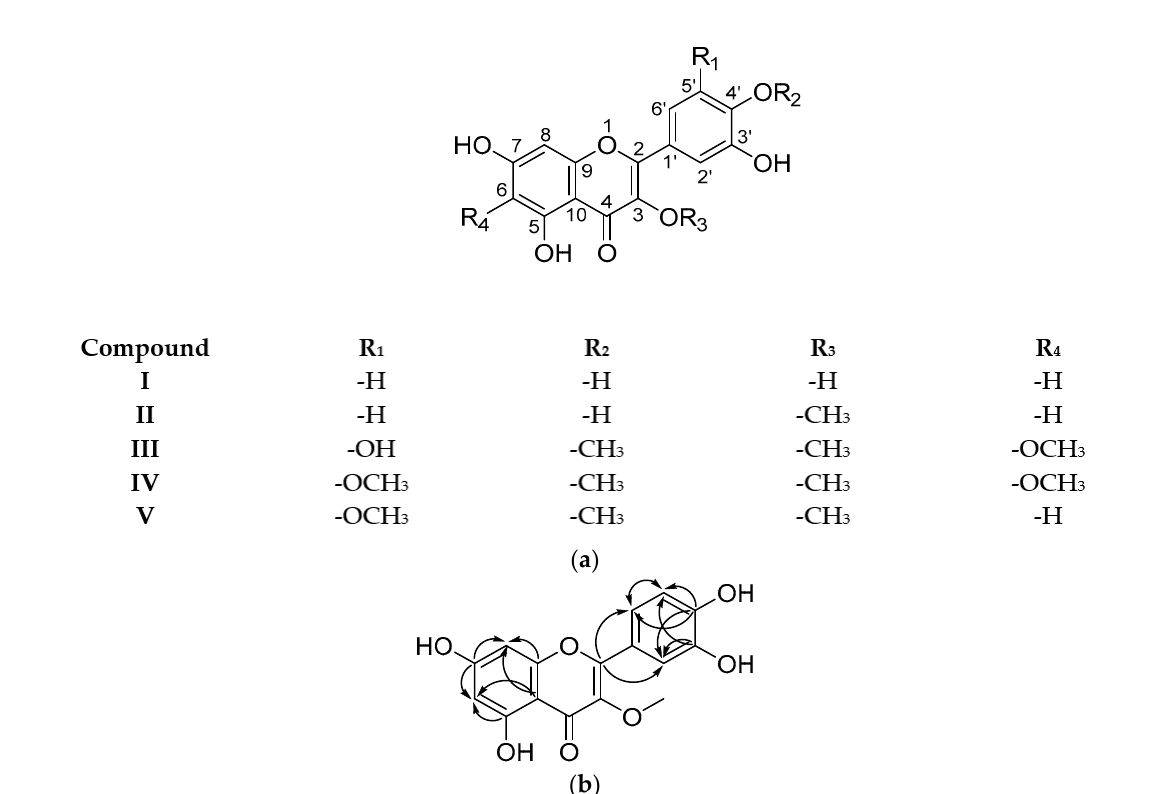
Figure 3. ( a ) Structures of compounds isolated from leaves of C. cowellii . ( b ) Correlations 2 J H-C and 3 J H-C observed in the HMBC spectra of compound II .